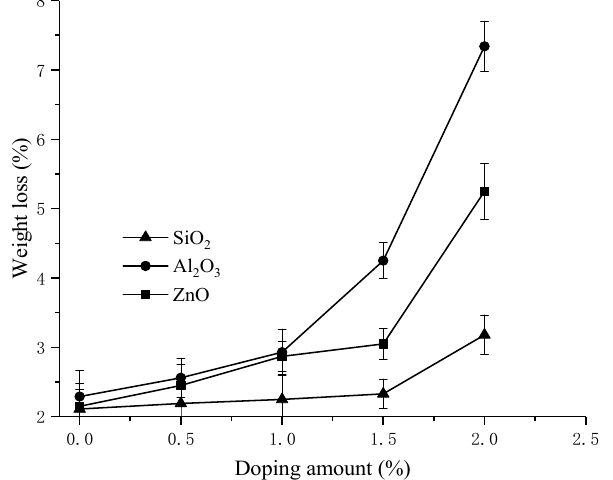
Figure 7. The weight loss values of the prepared membranes under different doping amounts of nano-SiO 2 , nano-Al 2 O 3 and nano-ZnO.